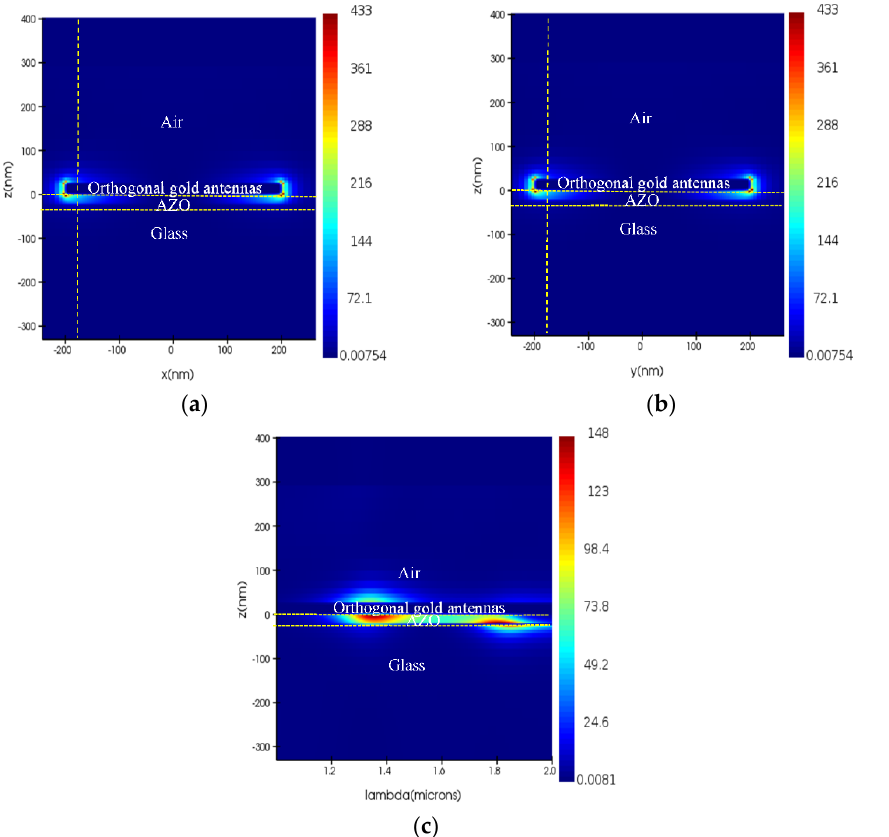
Figure 4. Electric field distribution and intensity enhancement of the resonance at a wavelength 1346 nm. ( a ) X polarization; ( b ) Y polarization; ( c ) Wavelength-dependent intensity enhancement.